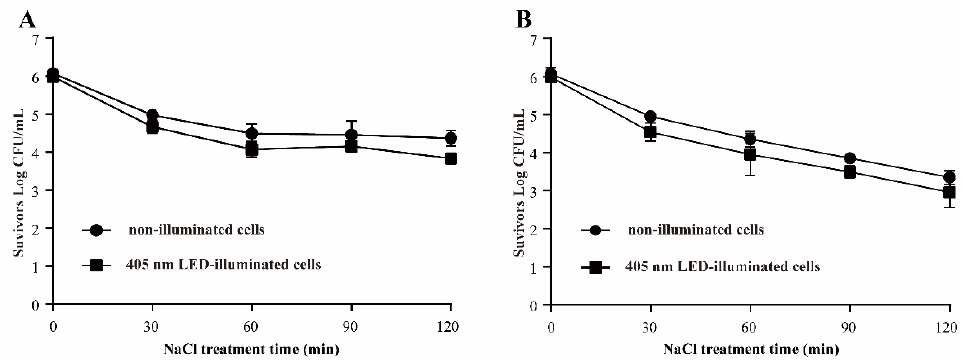
Figure 4. Survival of S . Typhimurium in 5% ( A ) and 10% NaCl ( B ). ( ● ) non-illuminated cells, ( ■ ) 405 nm LED-illuminated cells.